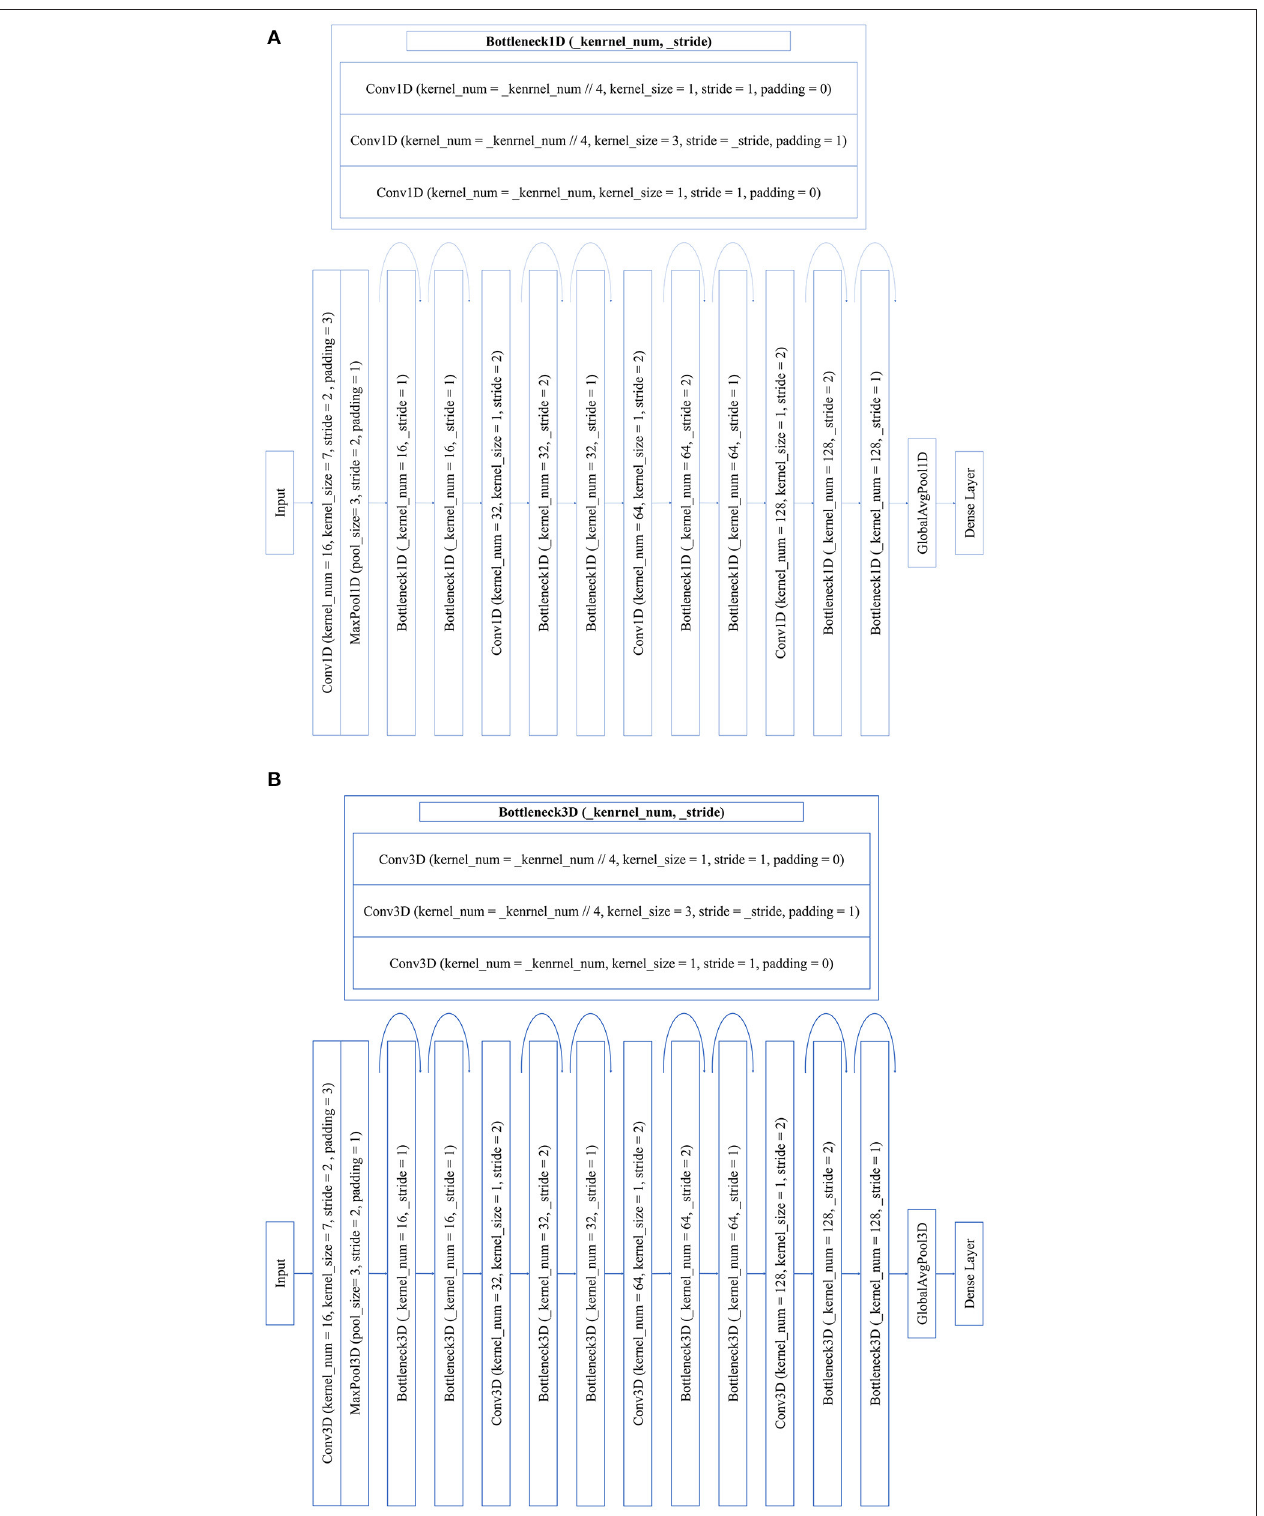
Frontiers in Plant Science | www.frontiersin.org